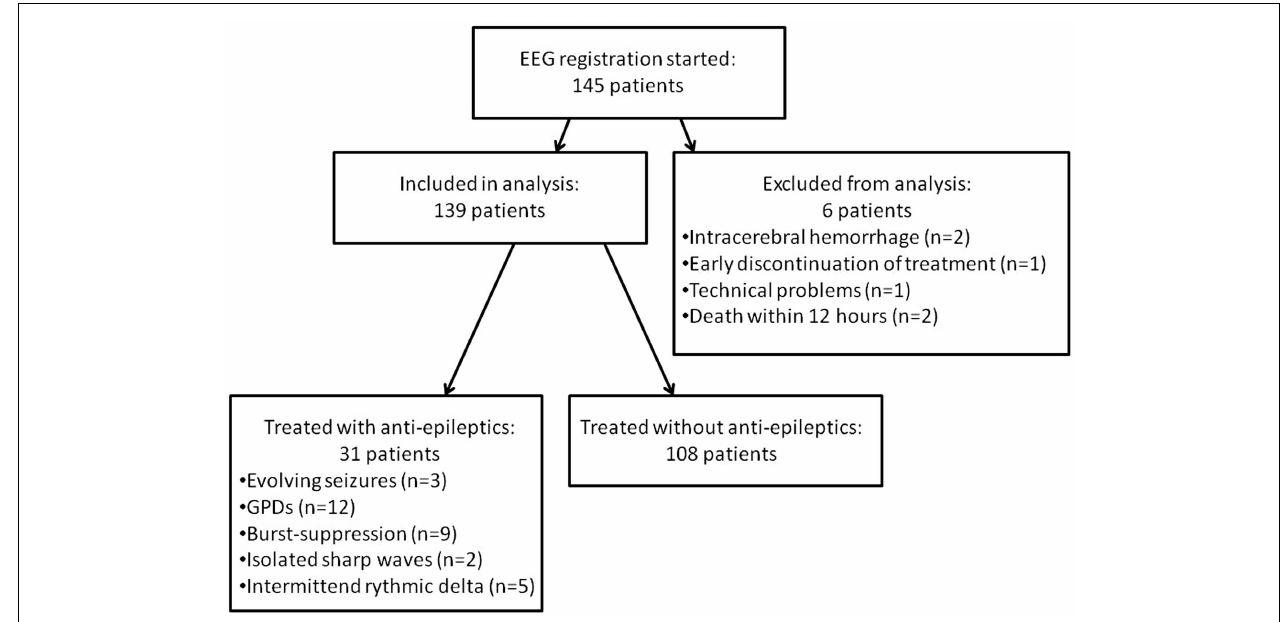
FIGURE 1 | Flowchart of included patients . GPDs indicate generalized periodic discharges. Burst-suppression patterns consisted of bursts resembling epileptiform discharges of 1 up to 5s.